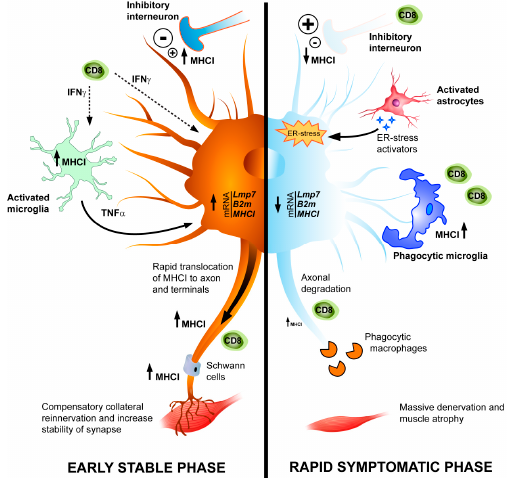
Figure 2. Schematic representation of dysregulation of MHCI in MNs during ALS pathology. Left side: in SOD1 G93A mice, at the early phase of the disease, a marked upregulation of mRNAs for MHCI and associated components, immunoproteasome (LMP7) and β 2 microglobulin ( β 2m), occurs in MNs in response to accumulation of misfolded proteins (i.e., mutant SOD1) and presumably to the release of pro-inflammatory cytokines from activated microglia and astrocytes. Once transduced, MHCI is rapidly translocated to motor axons and terminals leaving the soma almost deprived of MHCI protein. This is associated with recruitment of T cells in sciatic nerves and axon terminals. Since the retraction of damaged motor axons at the neuromuscular junctions is the earliest event in ALS, we hypothesize that the upregulation of MHCI in the periphery may activate cytotoxic T cells